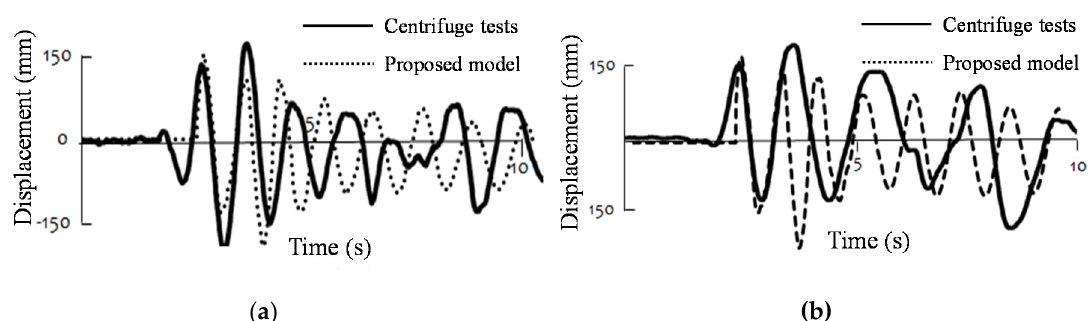
Figure 11. Comparison of pile head displacement: ( a ) Case 1 (D r = 55%) and ( b ) Case 2 (D r =